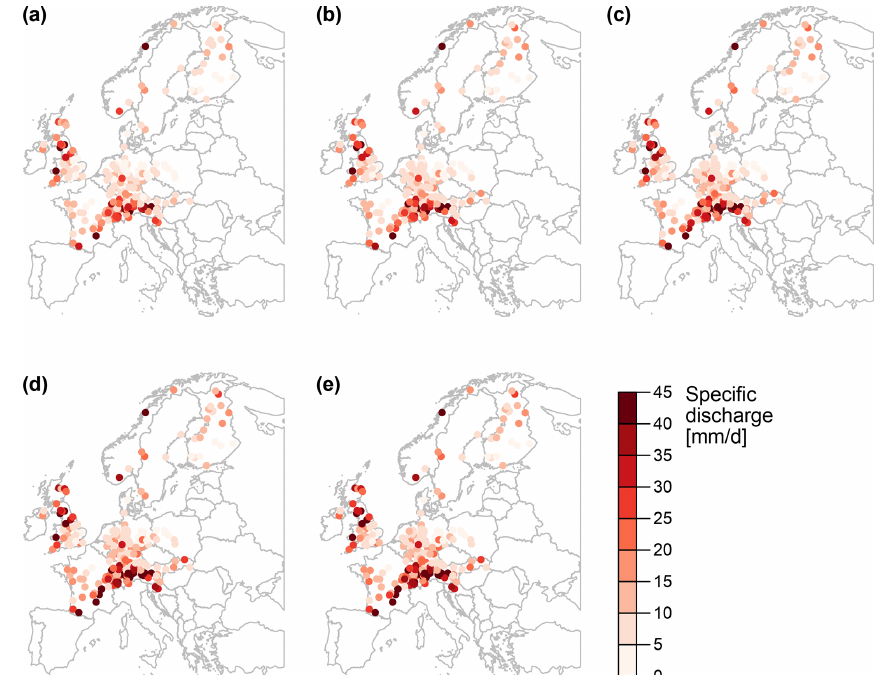
Figure 10. Theoretical flood quantiles corresponding to return periods of (a) 10, (b) 20, (c) 50, (d) 100, and (e) 200 years derived from pooling POT events extracted from time series simulated for 10 ensemble members and 13 lead times ( ≥ 528h; sample size = 2600; 13 lead times × 10 members × 20